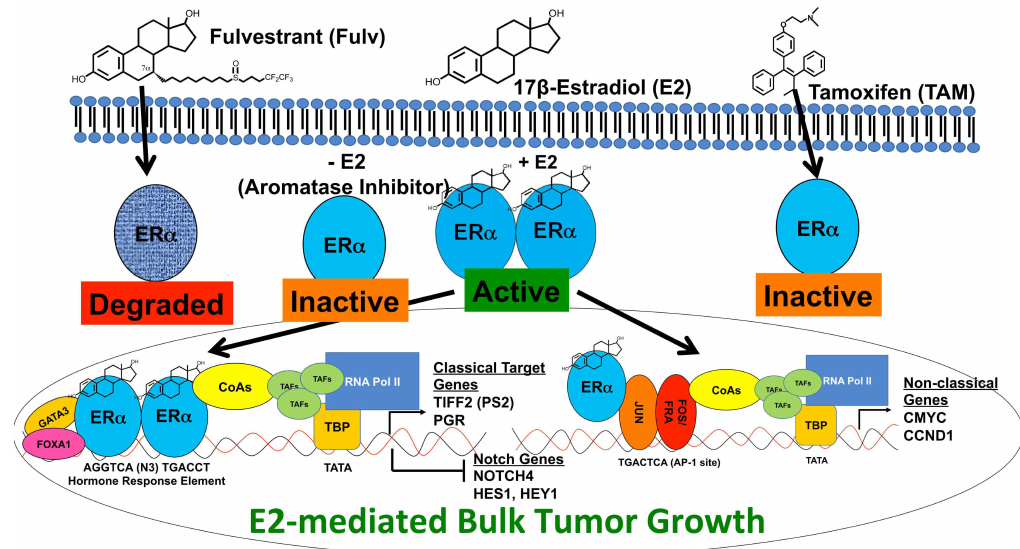
Figure 4. Estrogen signaling and regulation of Notch. The ER α ligand 17 β -estradiol (E2) crosses the plasma membrane and binds with high a ffi nity to the ER α monomer. Upon binding its ligand, ER α dimerizes and is in active conformation to enter the nucleus and activate transcription. Classical ER signaling requires the homodimers to bind hormone response elements. These hormone-response elements are frequently near FOXA1 and GATA3 binding elements. It is thought that ER homodimers are recruited to hormone-response elements through interaction with FOXA1 and / or GATA3. Once bound to the hormone-response elements, ER dimers recruit co-activator proteins, including p300 and other epigenetic modifying proteins, to unwind DNA and bring in the transcription initiation complex. Classical ER target genes, PGR , and TIFF2 are expressed, while other genes, such as NOTCH4, HES1 , and HEY1 , are repressed. Non-classical ER signaling requires interaction of an ER monomer or dimer with other transcription factors (i.e., AP-1) to promote activation of AP-1-driven genes including CMYC and CCND1 (Cyclin D1). In this fashion, E2 promotes tumor growth. Endocrine therapy includes treatment with estrogen-depleting (-E2) agents, such as aromatase inhibitors, and direct competitive inhibition, using tamoxifen (TAM) or fulvestrant (Fulv). TAM is an inhibitor of ER activity in breast cancer cells. Fulv is an ER degrader, and this results in complete downregulation of ER and ER signaling. Targeting ER expression and activity inhibits tumor growth. However, the consequence of ER inhibition is Notch activation and subsequent enrichment of Notch-high CSCs and